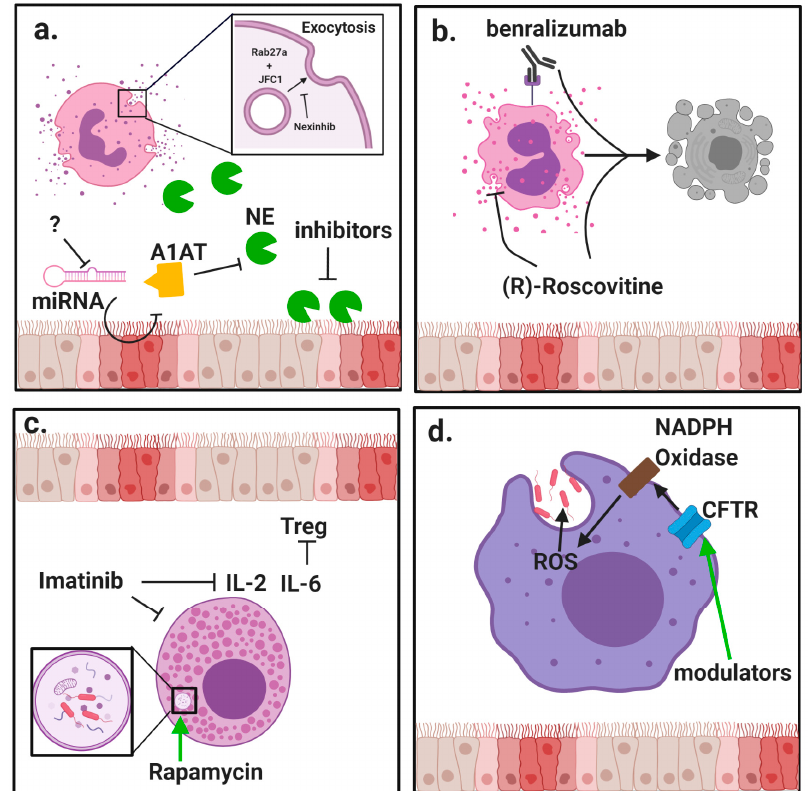
Figure 1. Modulation of innate immune cell function by protein ‐ directed therapies. Innate immune cells, including granulocytes and macrophages, have important roles in the pathophysiology of cystic fibrosis (CF) lung disease. (a) Neutrophils are massively recruited to the airways in CF and fail to clear pathogens despite their highly inflammatory activity. Neutrophils rapidly exocytosis their granules, releasing destructive enzyme such as neutrophil elastase (NE) into the extracellular space. Alpha ‐ 1 antitrypsin (A1AT) is a crucial anti ‐ protease in the lung but is overwhelmed by the burden of NE in advanced stages of disease. New potential mechanisms to counter NE ‐ driven inflammation include inhibition of micro RNA (miRNA) against A1AT and novel NE inhibitors with increased potency. Specific inhibition of granule exocytosis without affecting other functions can be achieved by neutrophil exocytosis inhibitors (nexinhibs) via inhibition of the interaction between the two docking proteins Rab27a and JFC1. (b) Eosinophils are much rarer than neutrophils but they can have a potent role in comorbidities with CF such as allergic bronchopulmonary aspergillosis (APBA). (R) ‐ Roscovitine may be effective in suppressing eosinophilic inflammation by blocking degranulation and inducing apoptosis. Benralizumab has also shown promise in promoting apoptosis in studies of asthma. (c) Mast cells are another rare granulocyte that present the opportunity for new therapies. Interleukin (IL) ‐ 6 blockade may relieve mast cell ‐ mediated suppression of regulatory T cells (Tregs), and this may be achieved through use of imatinib which has been shown to suppress mast cell